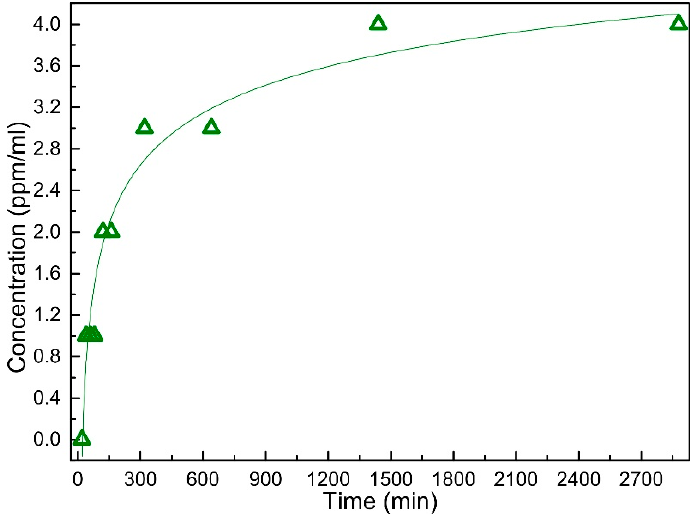
Figure 6. Silver ion concentration in purified water after soaking of synthetic silk coated with DLC:Ag (Sample 2 (3.12 at% Ag)) for different time durations obtained with AAS. It was obtained that the silver ion concentration increases sharply during the first 300 min and saturates approximately after 900 min. A double logarithm function ( y = a × ln( − b × ln( x ))) can be used to approximate the experimental curve, and a high correlation coefficient R 2 = 0.96 was obtained for the constants a = 4.36 and b = − 0.32.